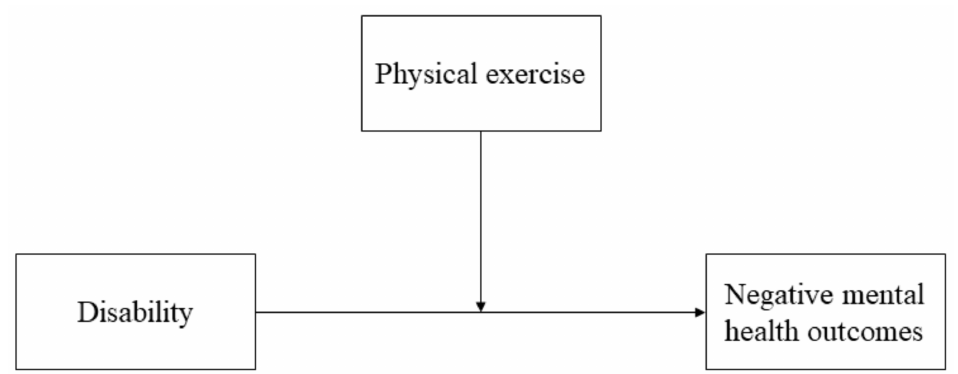
Figure 1. The hypothesized moderation